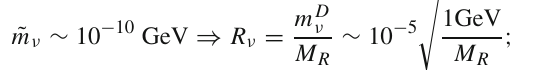
trino masses. One has